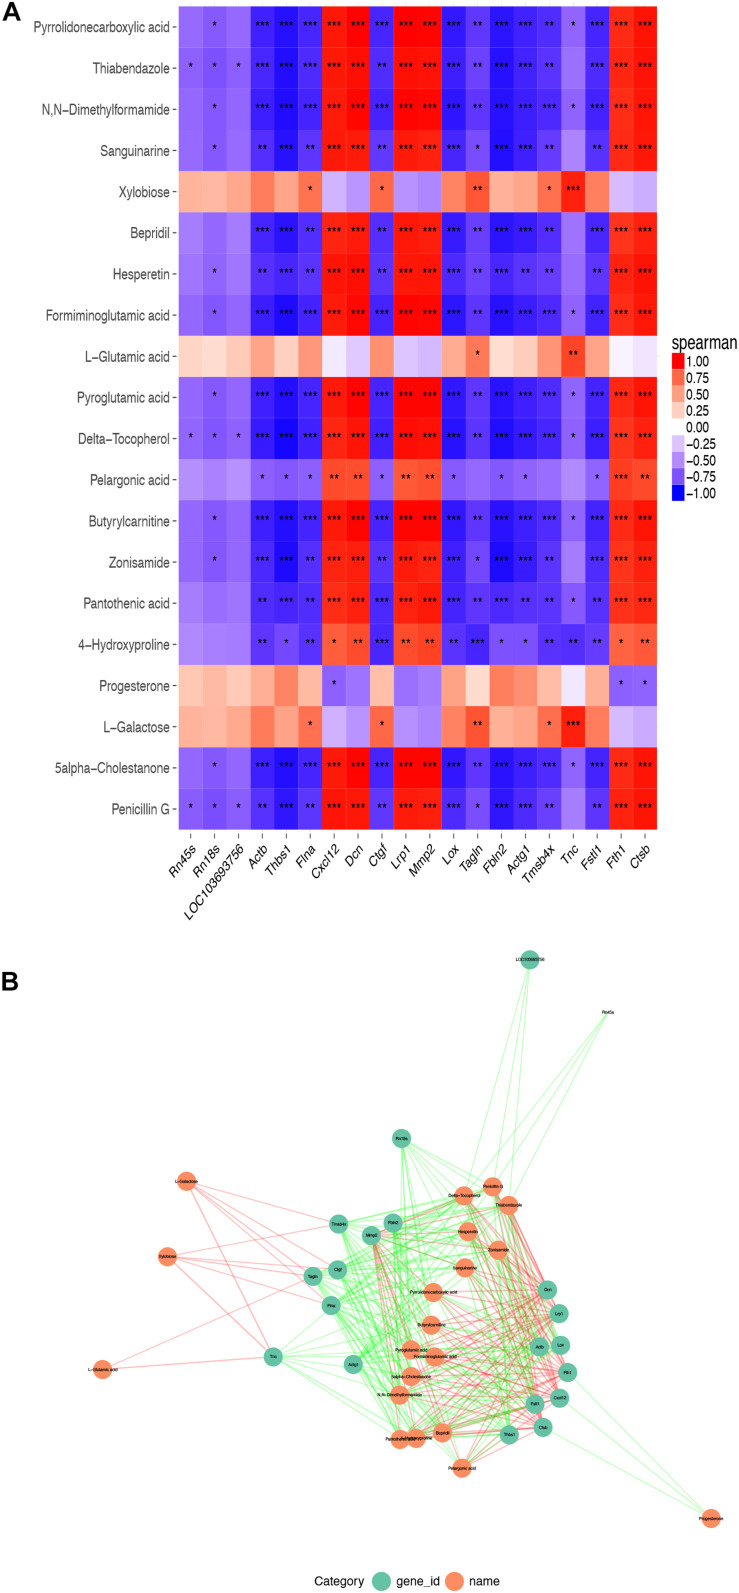
Correlation heat map and correlation network map of common DEGs and differential metabolites. (A) A heat map of the top 20 common DEGs and differential metabolites among SASCs, EASCs, and PASCs. (B) The PPI network of common DEGs and differential metabolites. Notes: ***P < 0.001, correlation; **P < 0.01, correlation; *P < 0.05, correlation.